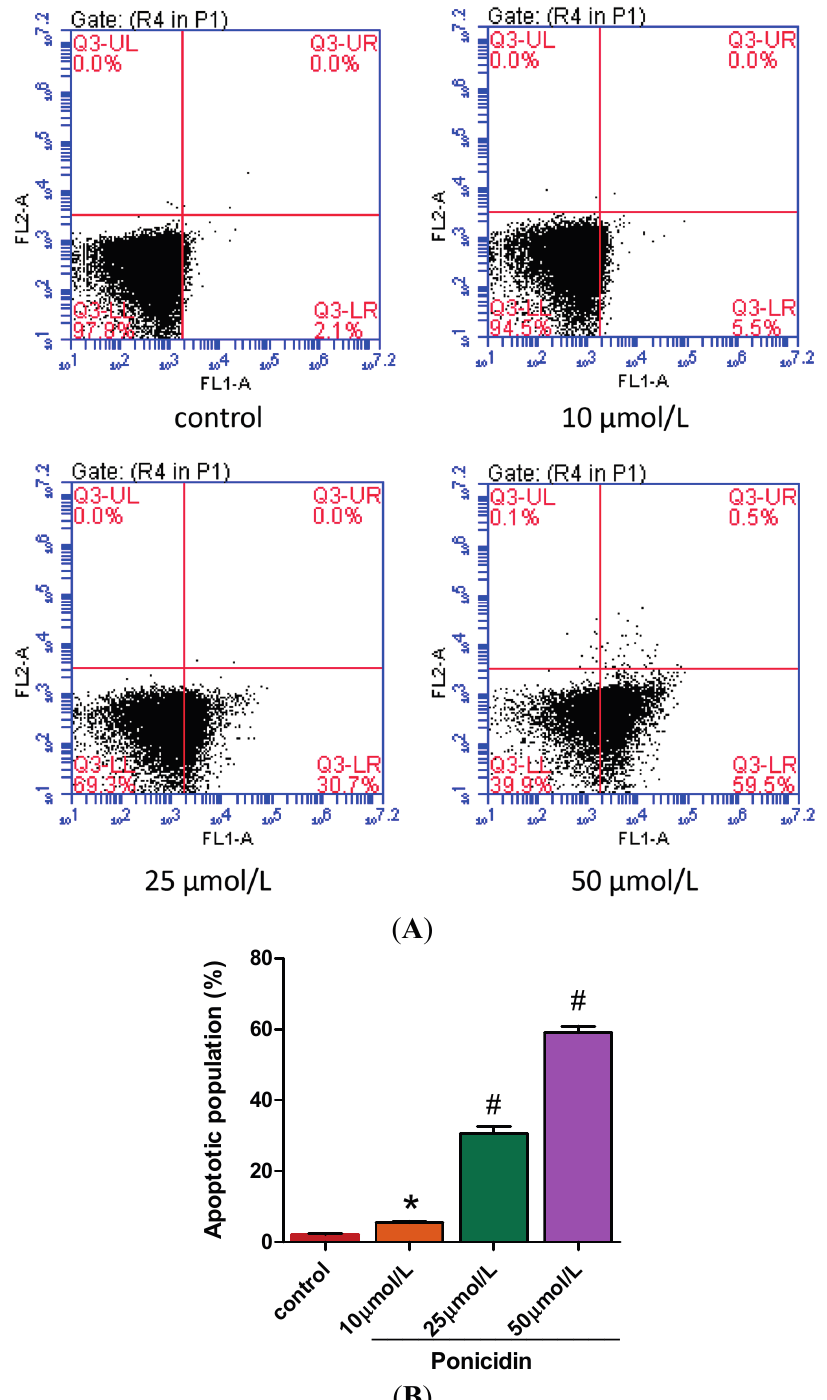
Figure 2. Effects of ponicidin on apoptosis of MKN28 cells. ( A ) Annexin-V/PI double stain assay and flow cytometry analysis were carried out to substantiate cell apoptosis; and ( B ) Treatment of ponicidin at doses of 10, 25 and 50 μ mol/L for 48 h dose-dependently increased the apoptotic populationof MKN28 cells. The lower left quadrant shows vital cells. The lower right quadrant indicates early apoptotic cells (Annexin-V positive but PI negative). The upper right quadrant represents late apoptotic cells or necrotic cells (double positive). * p < 0.05, # p <